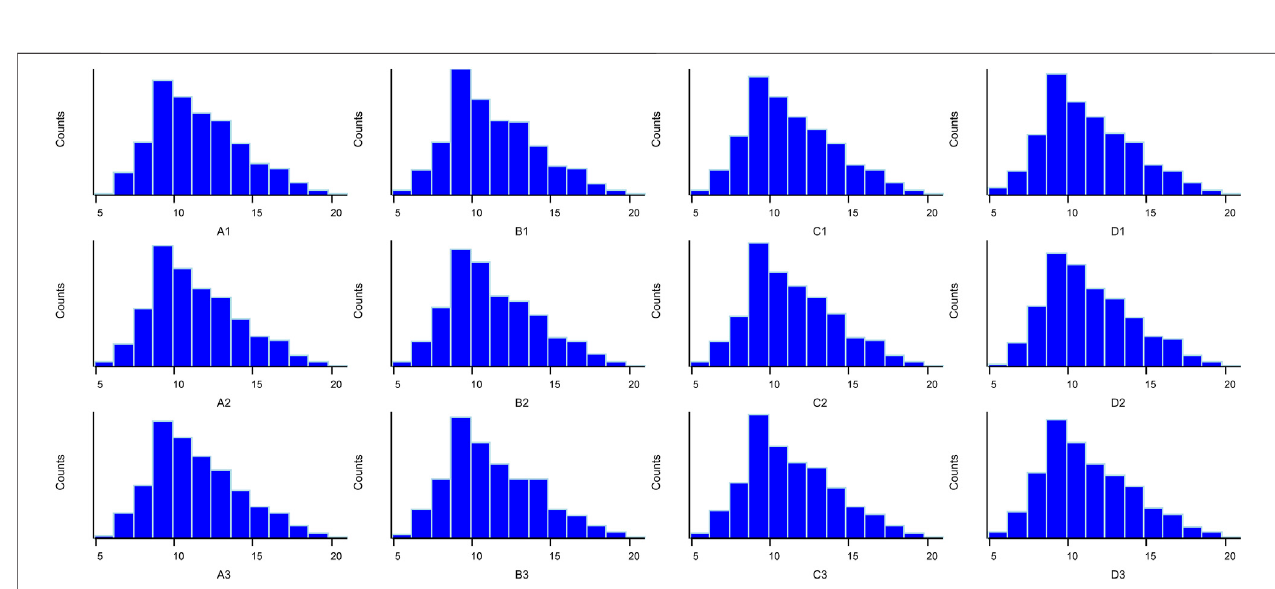
FIGURE 2 | Histogram of log2 protein intensity for each serum sample in TMT-based proteomic analysis.